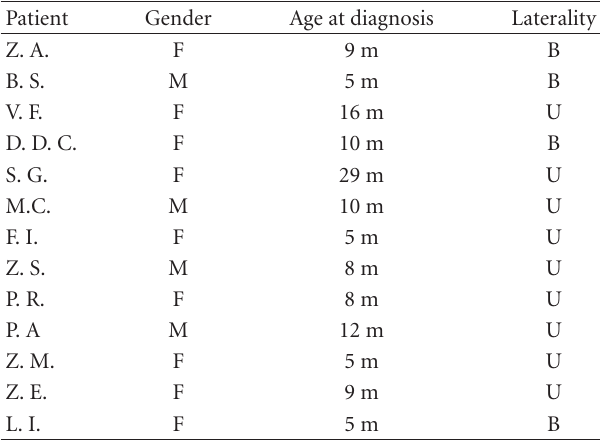
Table 4: 13 cases of 13q deletion syndrome referred to the Ocular Oncology Unit of the Department of Ophthalmology of the University of Siena (Italy). 9/13 expressed the unilateral disease phenotype. The calculation of the mean age at diagnosis reveals a value of 10